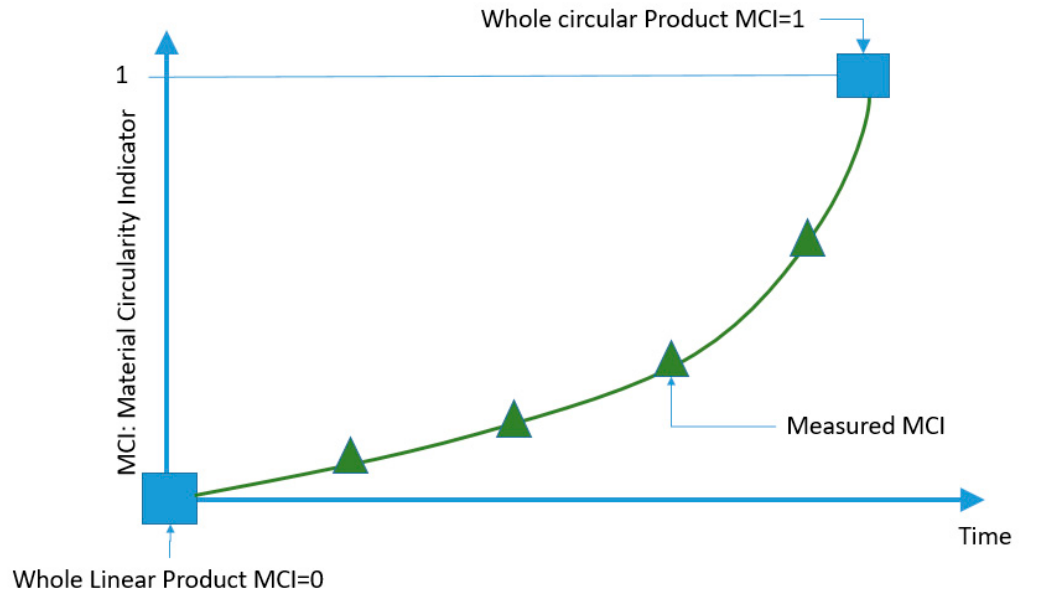
Figure 2. Transition towards Circularity.